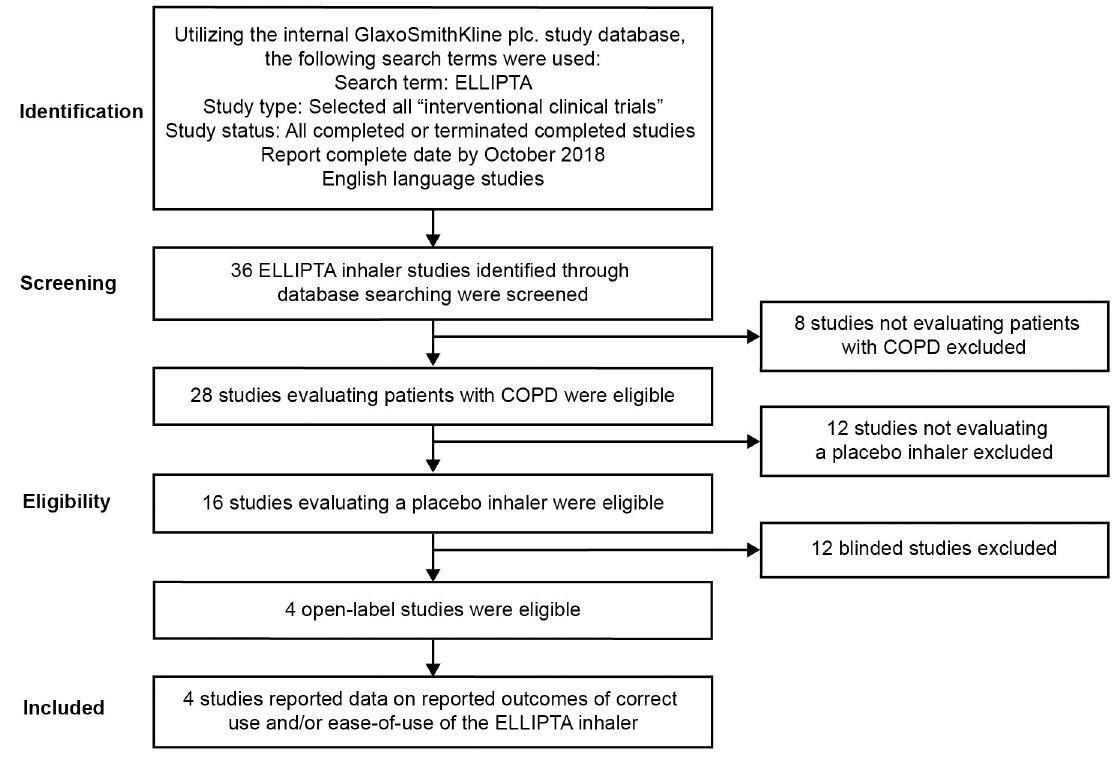
Fig 1. Database search flow diagram. COPD, chronic obstructive pulmonary disease.